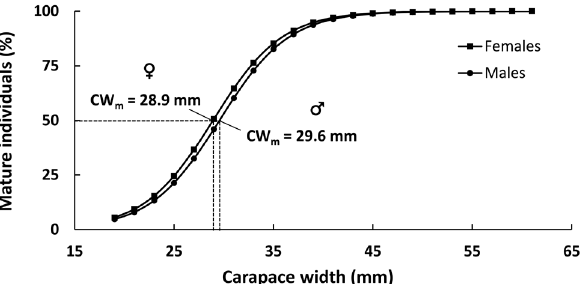
Figure 5. Length at first morphological maturity (CW females and males of Hepatus pudibundus off Sergipe (northeastern Brazil) in March/2015–May/2016. Table 2. Intercept ( a ) and slope ( b ) of total weight-carapace width relationships (TW= a∙ CW b ) for Hepatus pudibundus along the